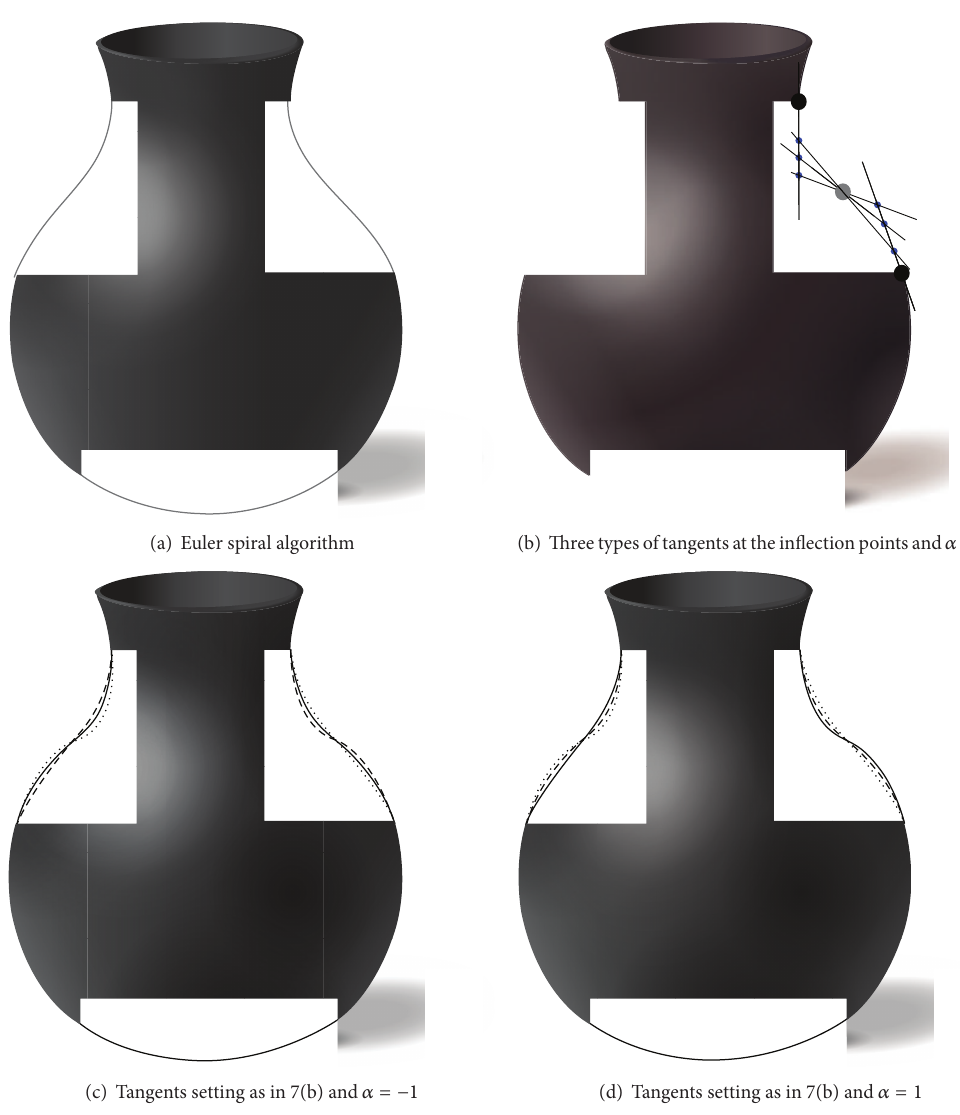
Figure 7: The results of fitting Euler spiral and LAC segment to a vase.